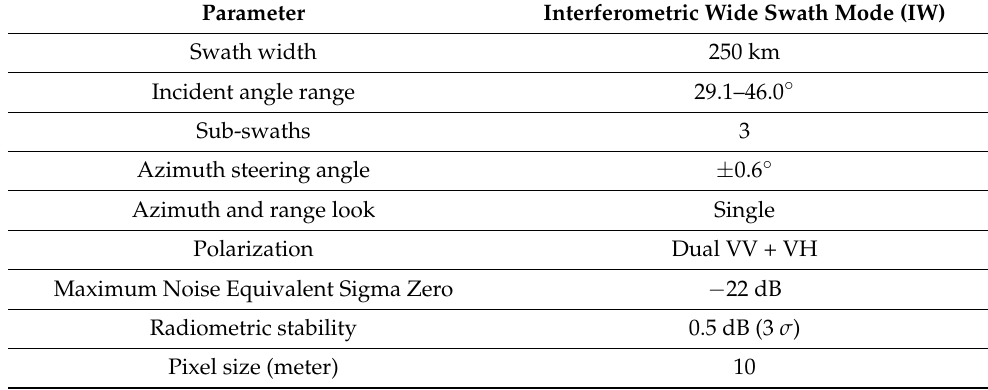
Table 1. Characteristics of Sentinel-1 [18].